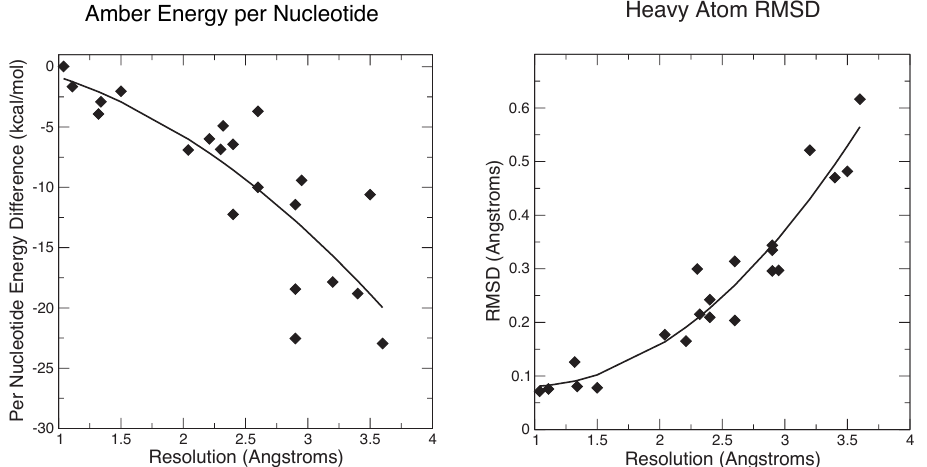
Figure 2. Energies and structural deviations for Amber and conventional refinements. The left panel shows the difference in Amber energy (per nucleotide) between Amber and conventional refinements; negative values indicate that the Amber refinement has a lower energy. The Amber energy estimate includes the solvation free energy estimated from